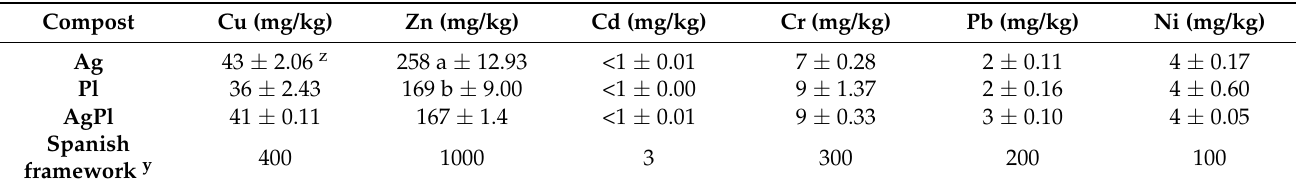
Table 2. Heavy metal concentration of 100% A. bisporus (Ag), 100% P. ostreatus (Pl), and 70% A. bisporus: 30% P. ostreatus (AgPl) composts.